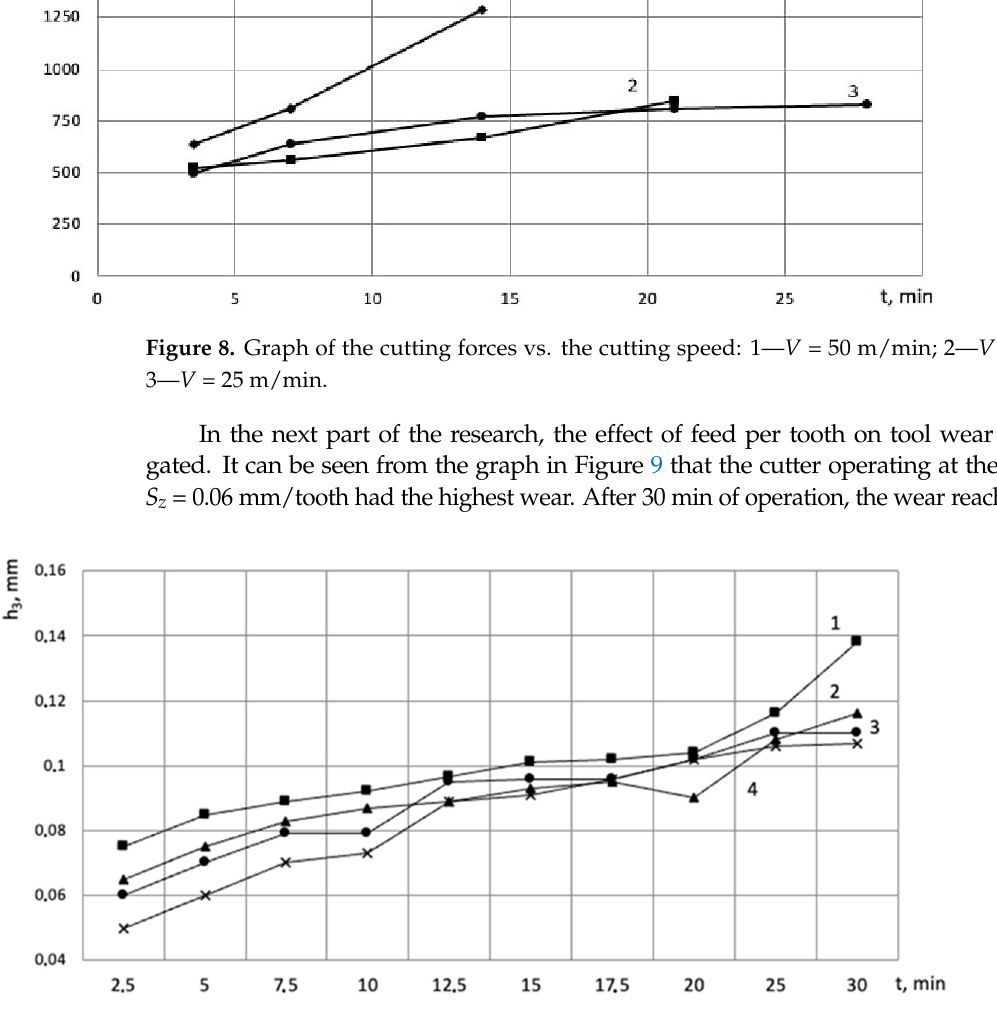
Figure 9. Graph representing flank wear land vs. feed per tooth: 1— S z = 0.06; 2— S z = 0.04; 3— S z = 0.03; 4— S z = 0.05.